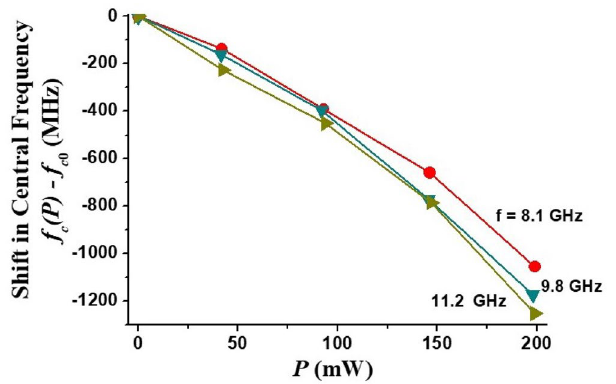
Figure 9. Shift in the pass filter center frequency as a function of the applied electric